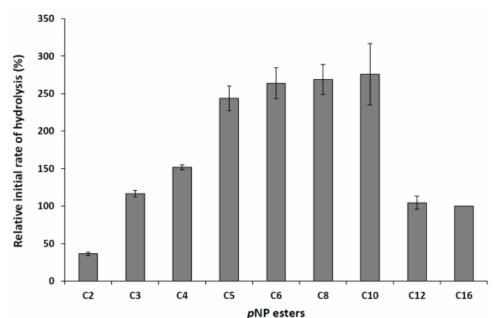
Figure 3. Specificity of the M. echinosphaera CBS 575.75 lipase towards p NP ester substrates (C2: p NP-acetate, C3: p NP-propionate, C4: p NP-butyrate, C5: p NP-valerate, C6: p NP-caproate, C8: p NP-caprylate, C10: p NP-decanoate, C12: p NP-dodecanoate, C16: p NPP). Reactions were performed at 25 ◦ C for 30 min in 50 mM sodium phosphate buffer (pH 6.8) contained 0.75 mM